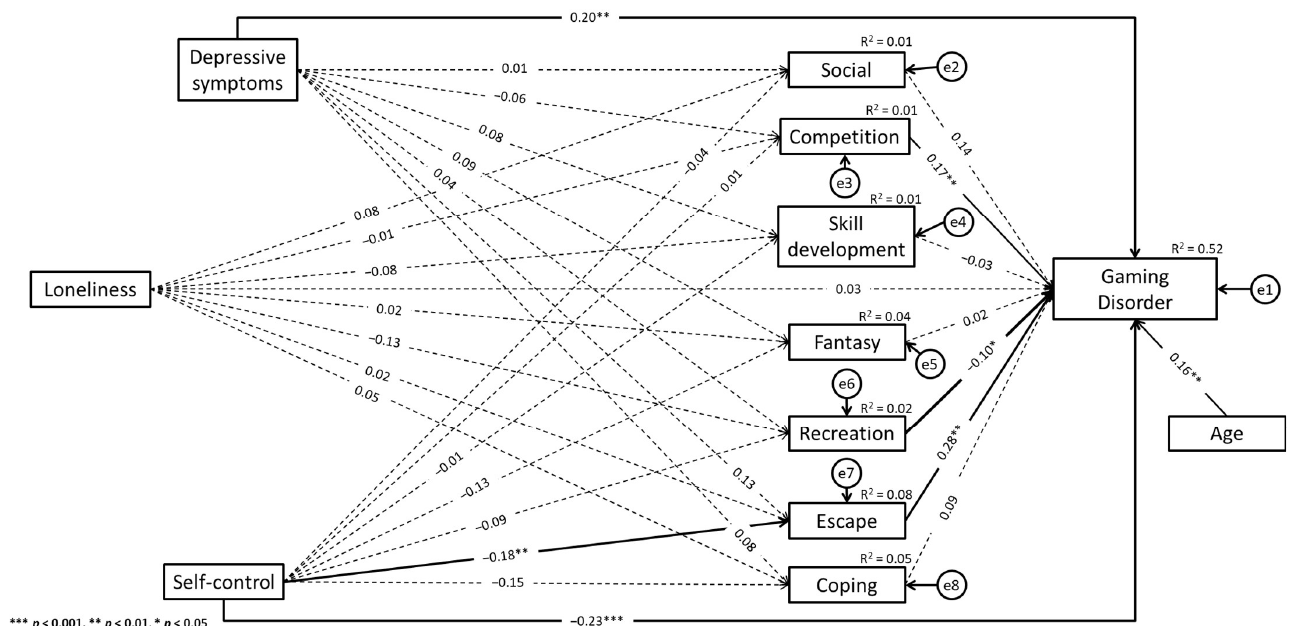
Figure 2. Paths model of the relationship between variables in female gamers group.